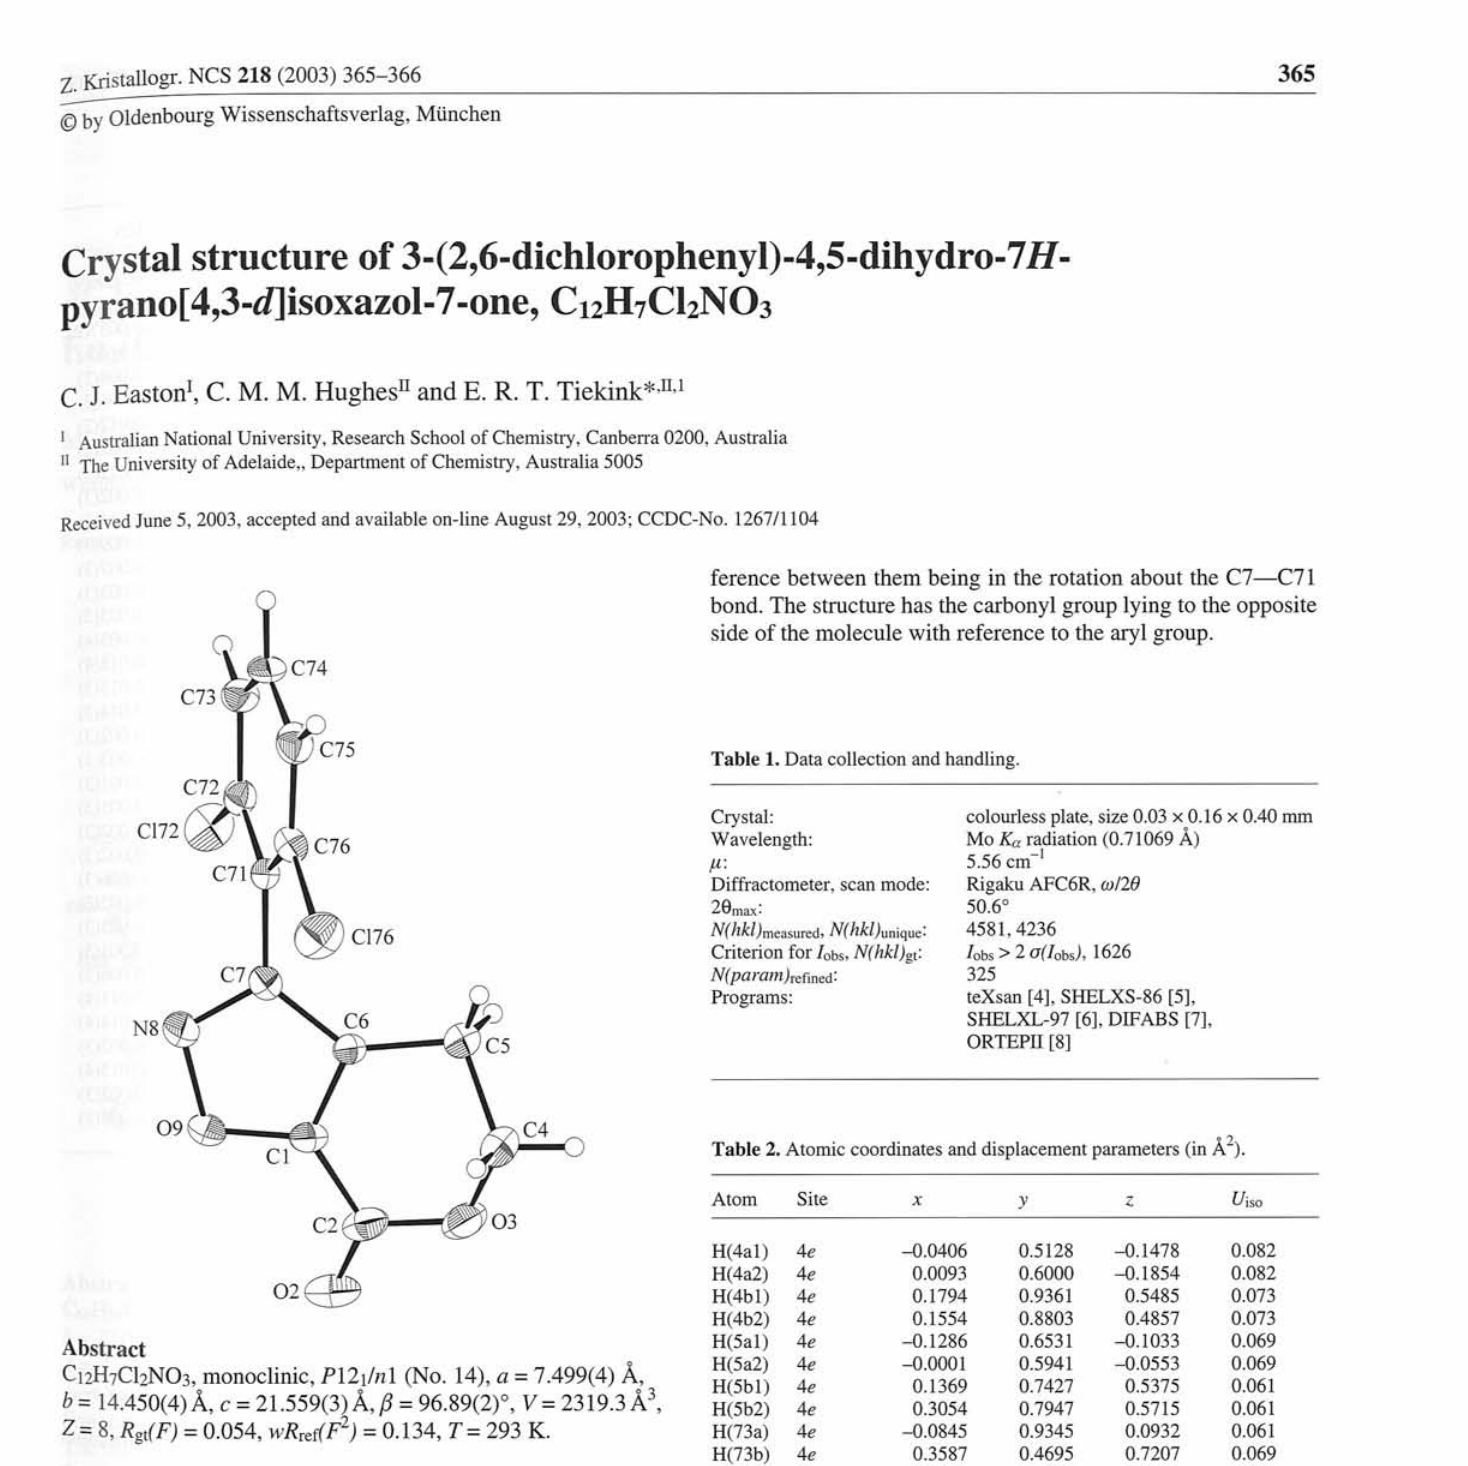
Table 2. Atomic coordinates and displacement parameters (in